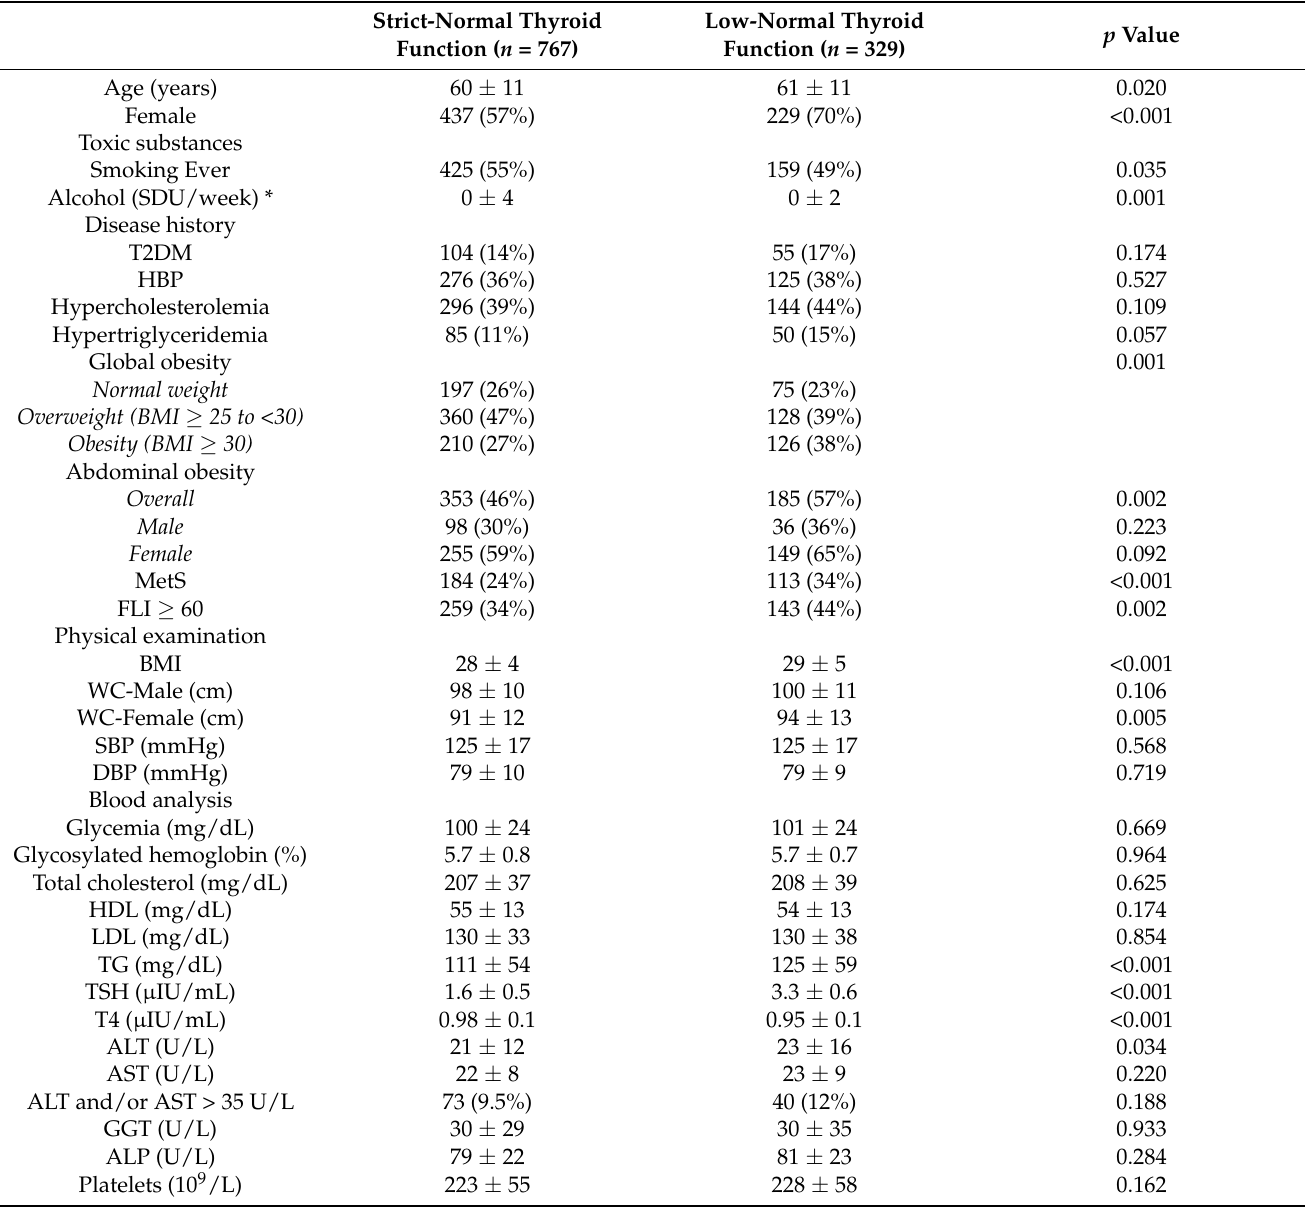
Table 1. Basal characteristics of the subjects according to thyroid function ( n =